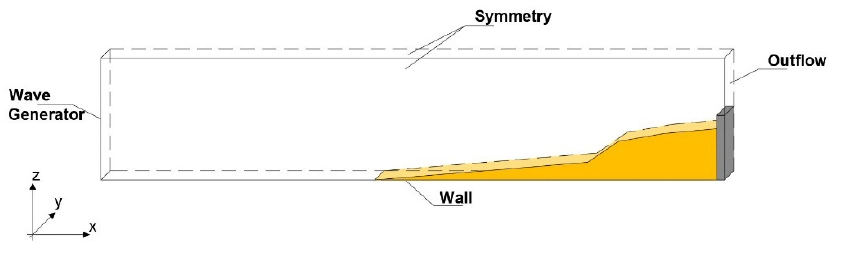
Table 4. General Parameter settings in CFD numerical simulation.